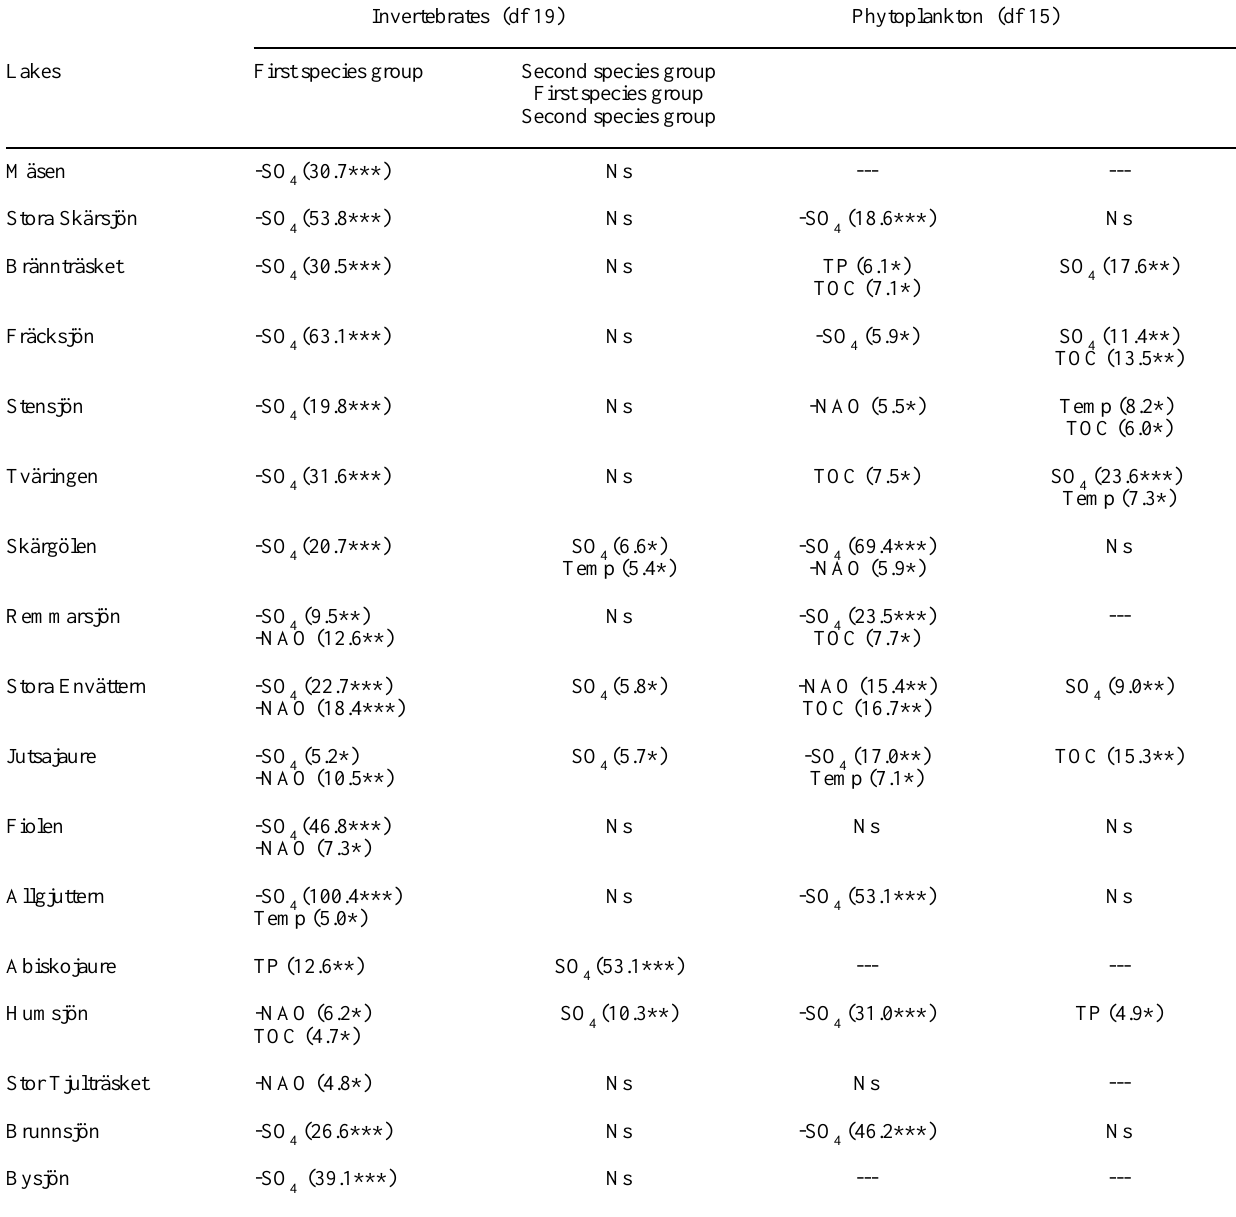
Table 1 . Summary of generalized linear model results. Shown are environmental variables that explained the temporal dynamics of different species groups (associated with canonical axes 1 and 2, respectively) revealed by time series modeling of invertebrates and phytoplankton. Degrees of freedom (df), F-ratios, and significance levels for each variable are given in parentheses (* P < 0.05; ** P < 0.01, *** P < 0.001). Abbreviations: TP, total phosphorus;, TOC, total organic carbon; Temp, temperature; SO concentration; NAO, North Atlantic Oscillation winter index; Ns, generalized linear model not significant; and ---, no significant temporal structure revealed by time series